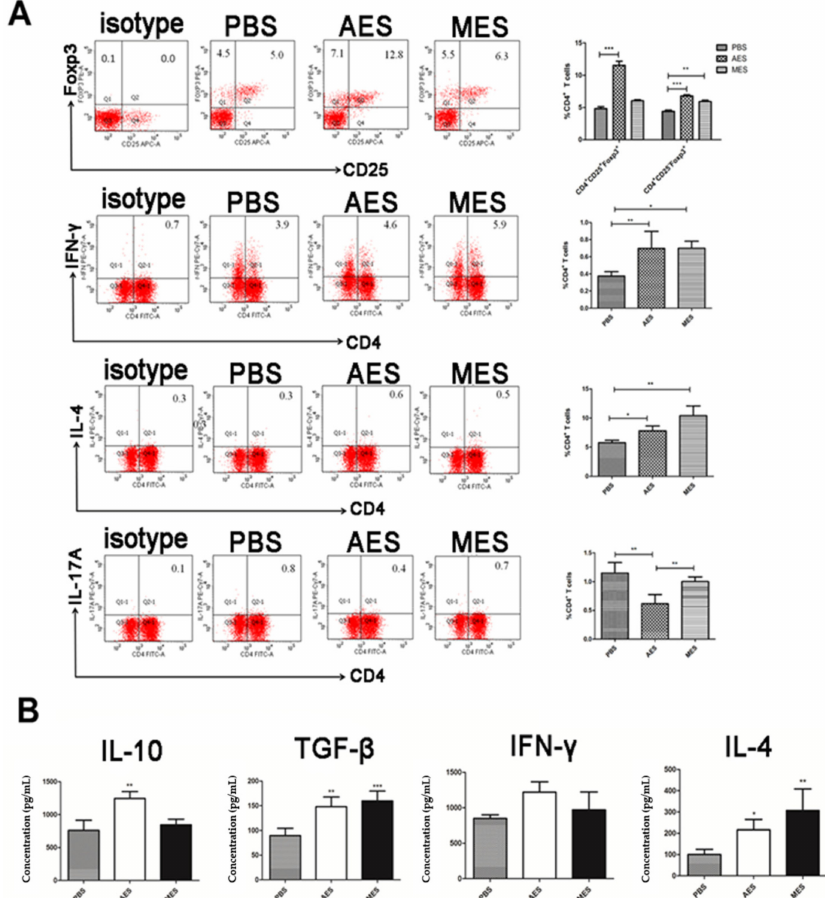
Figure 3. The di ff erentiation of Th1, Th2, Th17, and Treg cells and secreted cytokines in mice immunized with adult worm excretory–secretory products (AES) or muscle larvae excretory–secretory products (MES): ( A ) The splenocytes were isolated from mice immunized with AES and MES sorted for CD4, CD25, Foxp3 and Th1, Th2, and Th17 by FACS. ( B ) Splenocyte supernatants were harvested after being cultured 72 h with PMA / ionomycin, and the cytokine profile in the culture was examined by ELISA. Results are expressed as means ± SDs from 3 independent experiments. * p < 0.05; ** p < 0.01; *** p < 0.001, compared to phosphate-bu ff ered saline (PBS) or indicated control. 3.4. The mRNA Expression Profile Further Confirmed that AES Immunization Upregulated the Expressions